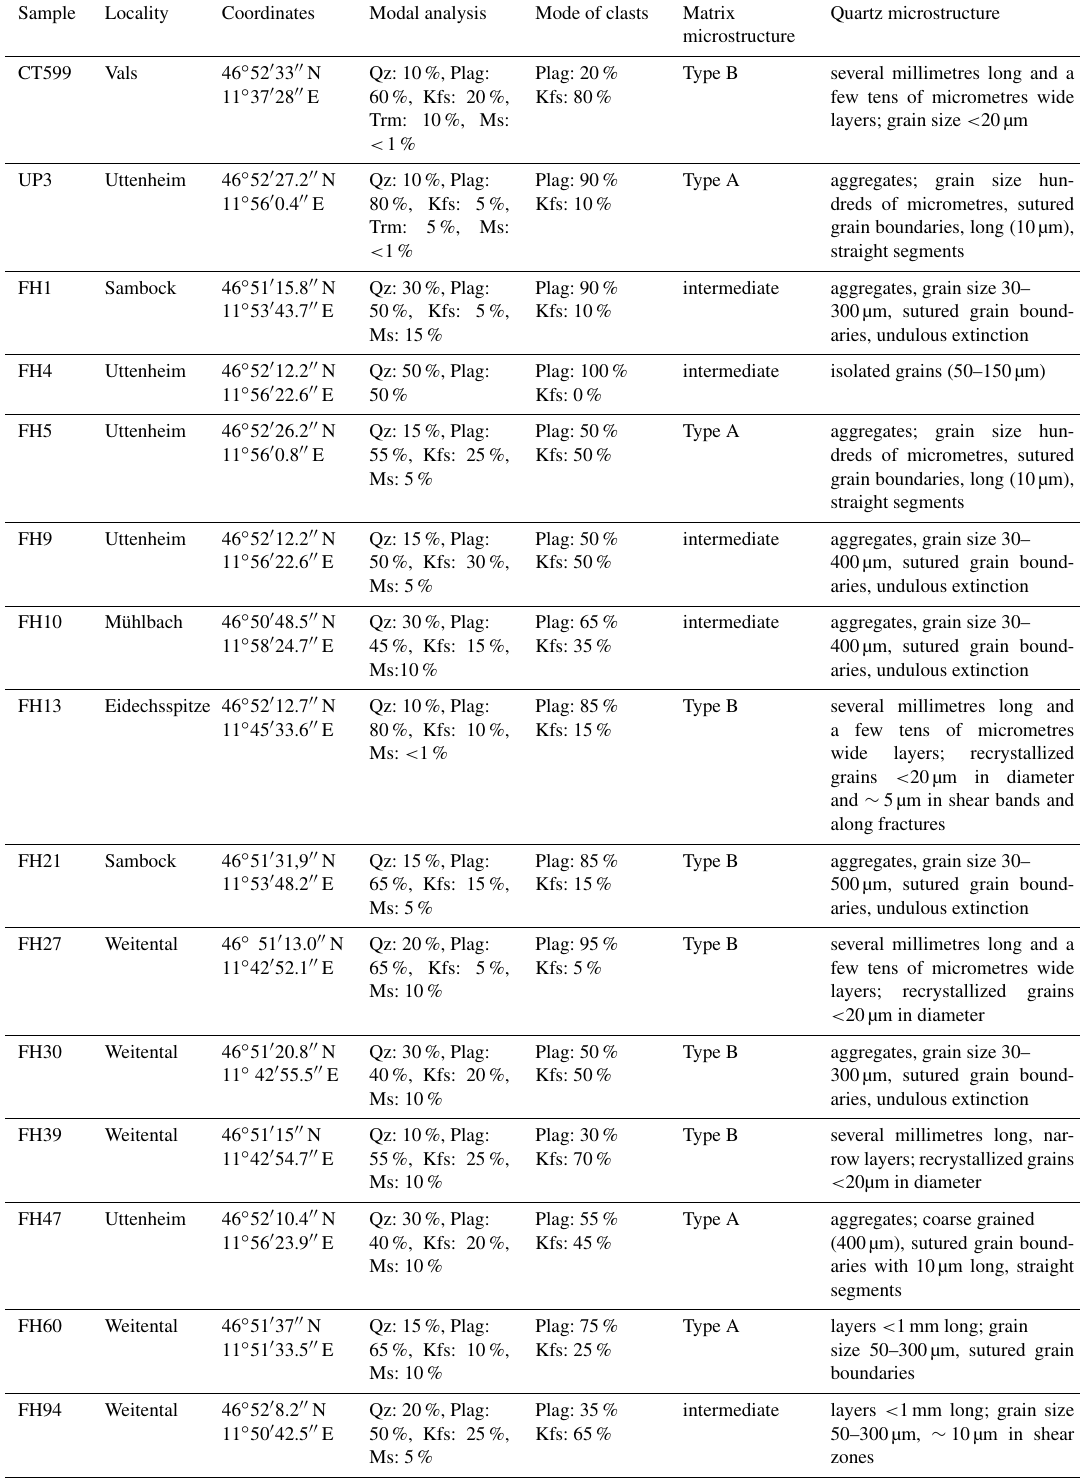
Table A1. Overview of the investigated